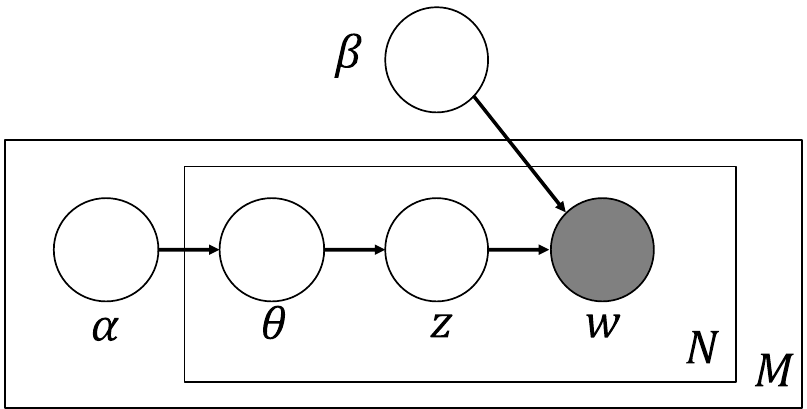
Figure 3. Graphical model representation of latent dirichlet allocation (LDA) (source: Blei et al. [49]). LDAvis is used to visualize LDA [50]. The saliency of term w in any topic t is defined by Equation (5). In addition, the number of topics included in each cluster is estimated [51].